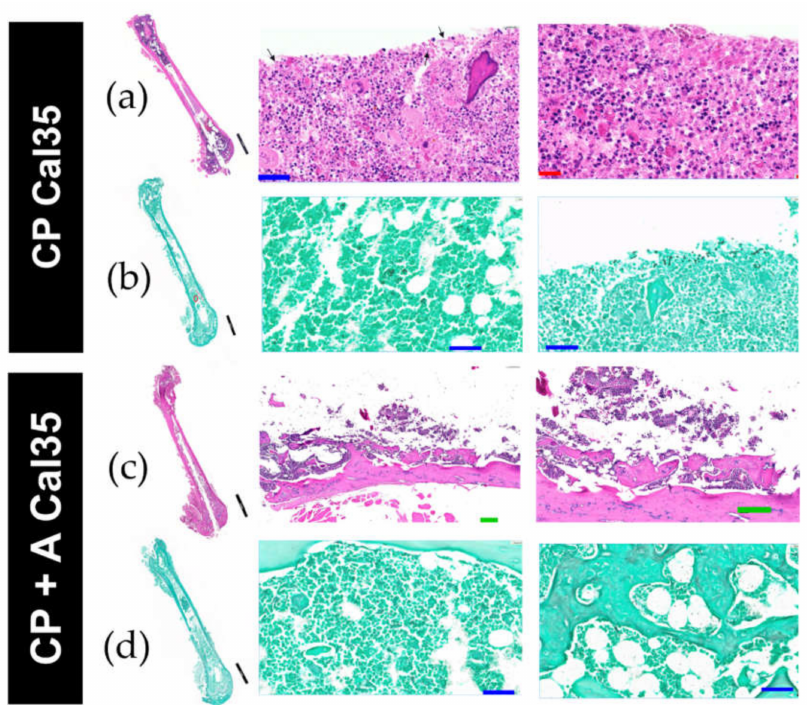
Figure 6. Histological images with H&E stain ( a , c ) and Grocott’s stain ( b , d ) of Cal-35–infected mice with implant without CP coating ( a , b ) and mice infected with implant and anidulafungin coating CP + A ( c , d ). The black, green, blue, and red bars represent 2 mm, 200 µ m, 50 µ m, and 20 µ m,